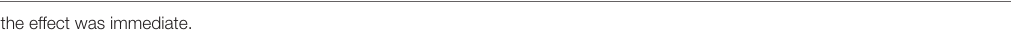
The first time I tried Modafinil the effect was immediate.